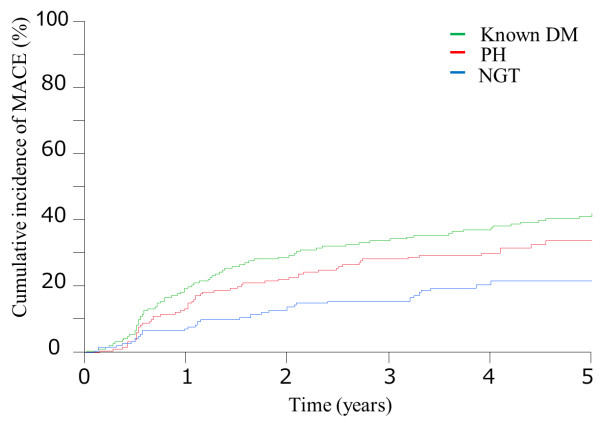
Kaplan-Meier plot of the cumulative incidence of the study endpoint between the three groups. The study endpoint was defined as cardiovascular death, myocardial infarction, stroke, and clinically-driven revascularization. Known DM = diabetes mellitus (green line); NGT = normal glucose tolerance (blue line); PH = post-challenge hyperglycemia (red line).